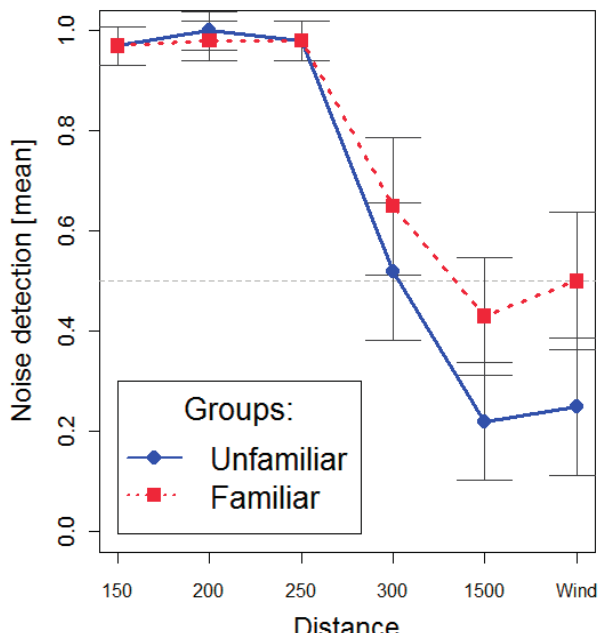
Figure 4. Noise detection ratings as a function of group and